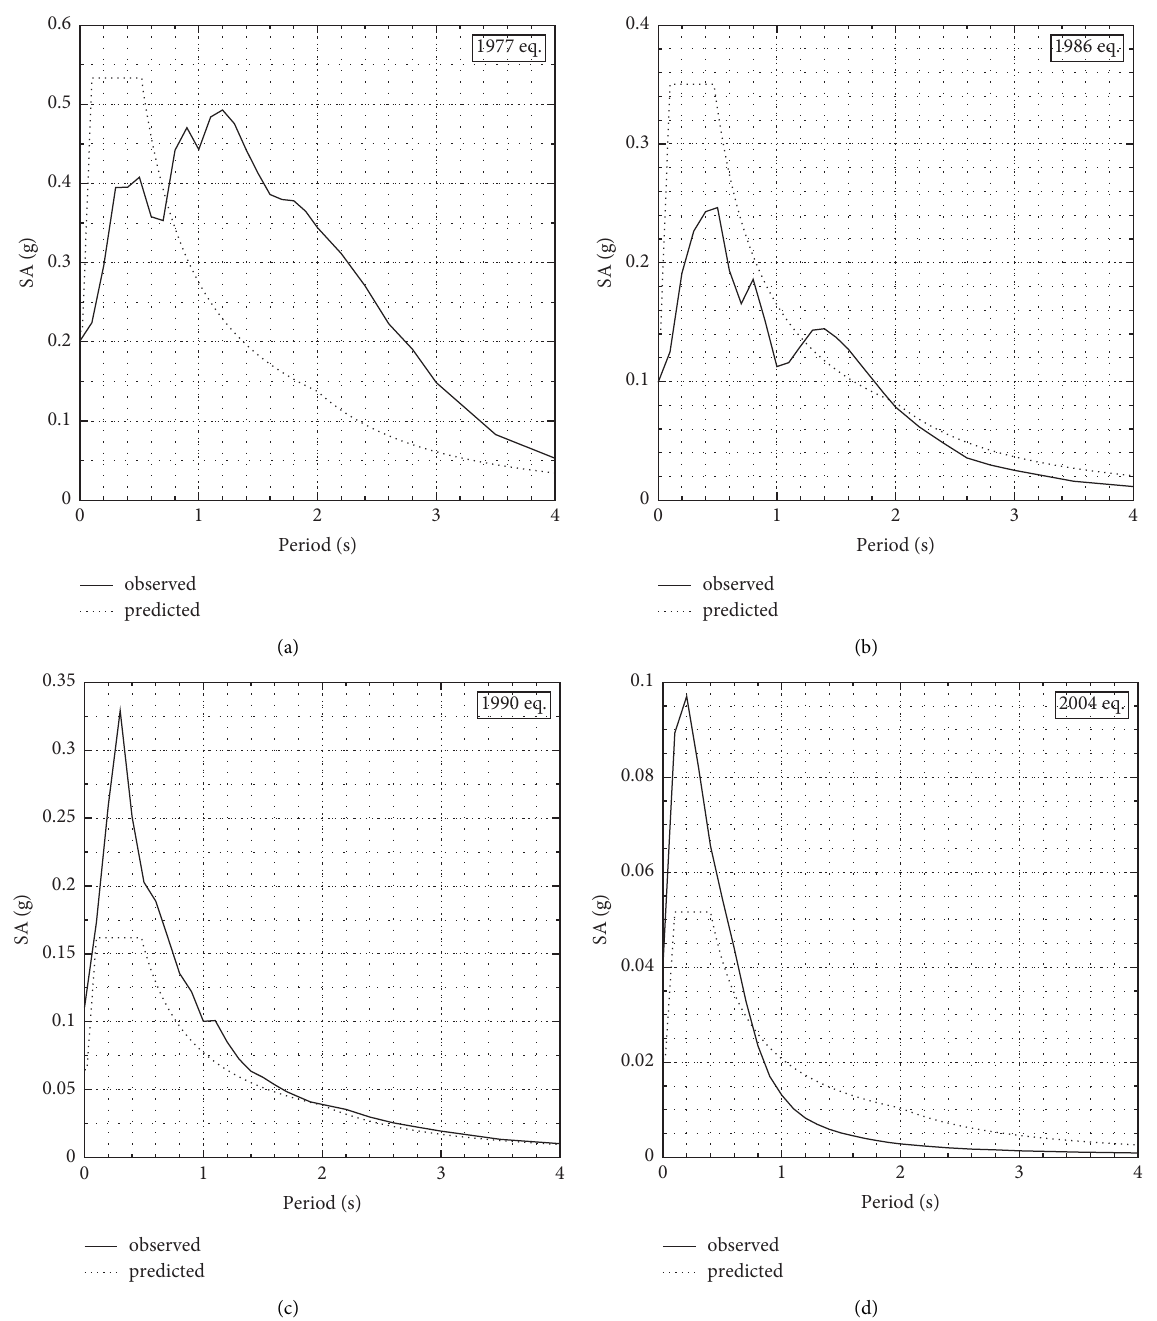
Figure 14: Comparison between the observed acceleration response spectra and the design response spectra according to the Eurocode 8 draft [30] for (a) 1977 earthquake; (b) 1986 earthquake; (c) 1990 earthquake; and (d) 2004 earthquake.